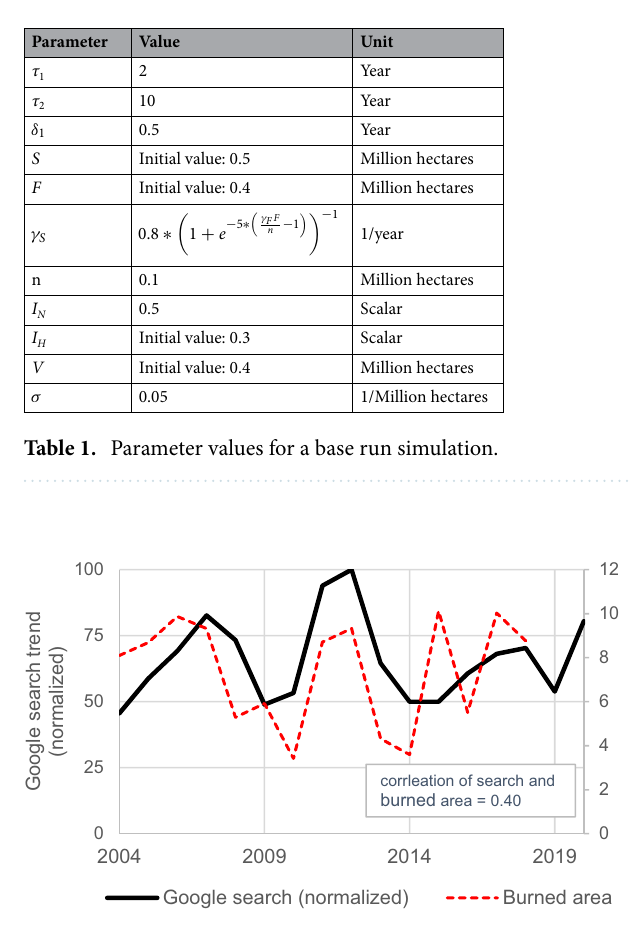
Figure 4. Google search trend for "wildfire" in the U.S. and its correlation with the annual burned